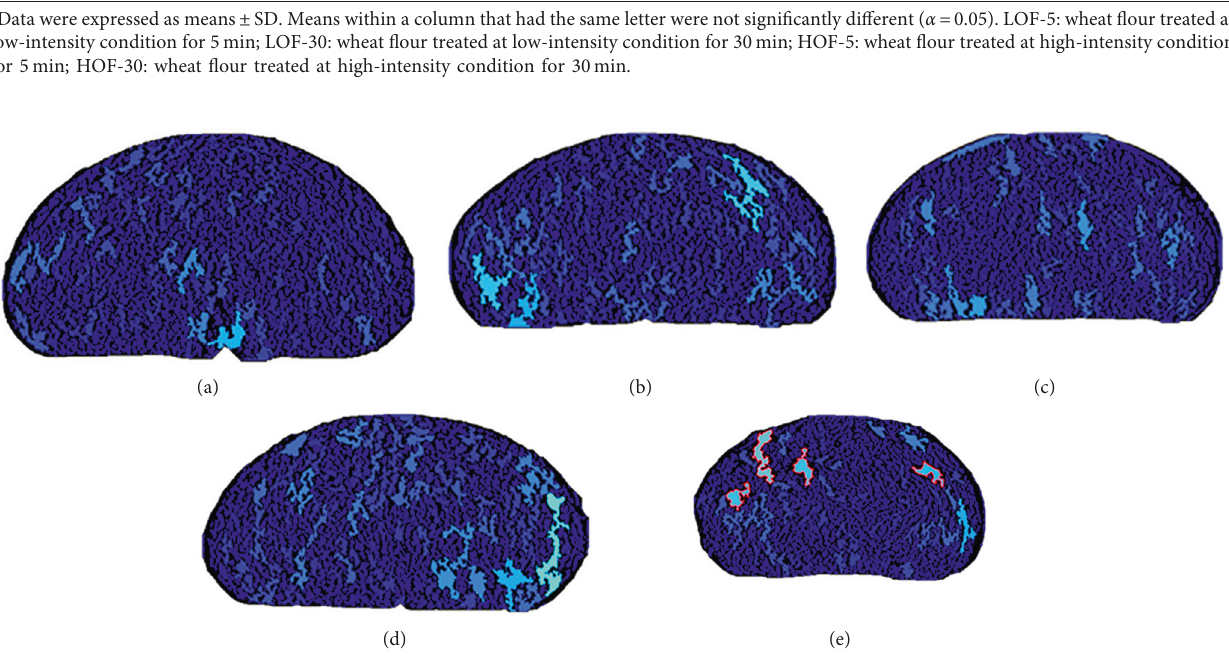
Figure 7: C-cell images of steamed breads made from native and ozone-treated wheat flours. (a) Native flour; (b) LOF-5 (wheat flour treated at low-intensity condition for 5 min); (c) LOF-30 (wheat flour treated at low-intensity condition for 30min); (d) HOF-5 (wheat flour treated at high-intensity condition for 5min); (d) HOF-30 (wheat flour treated at high-intensity condition for 30